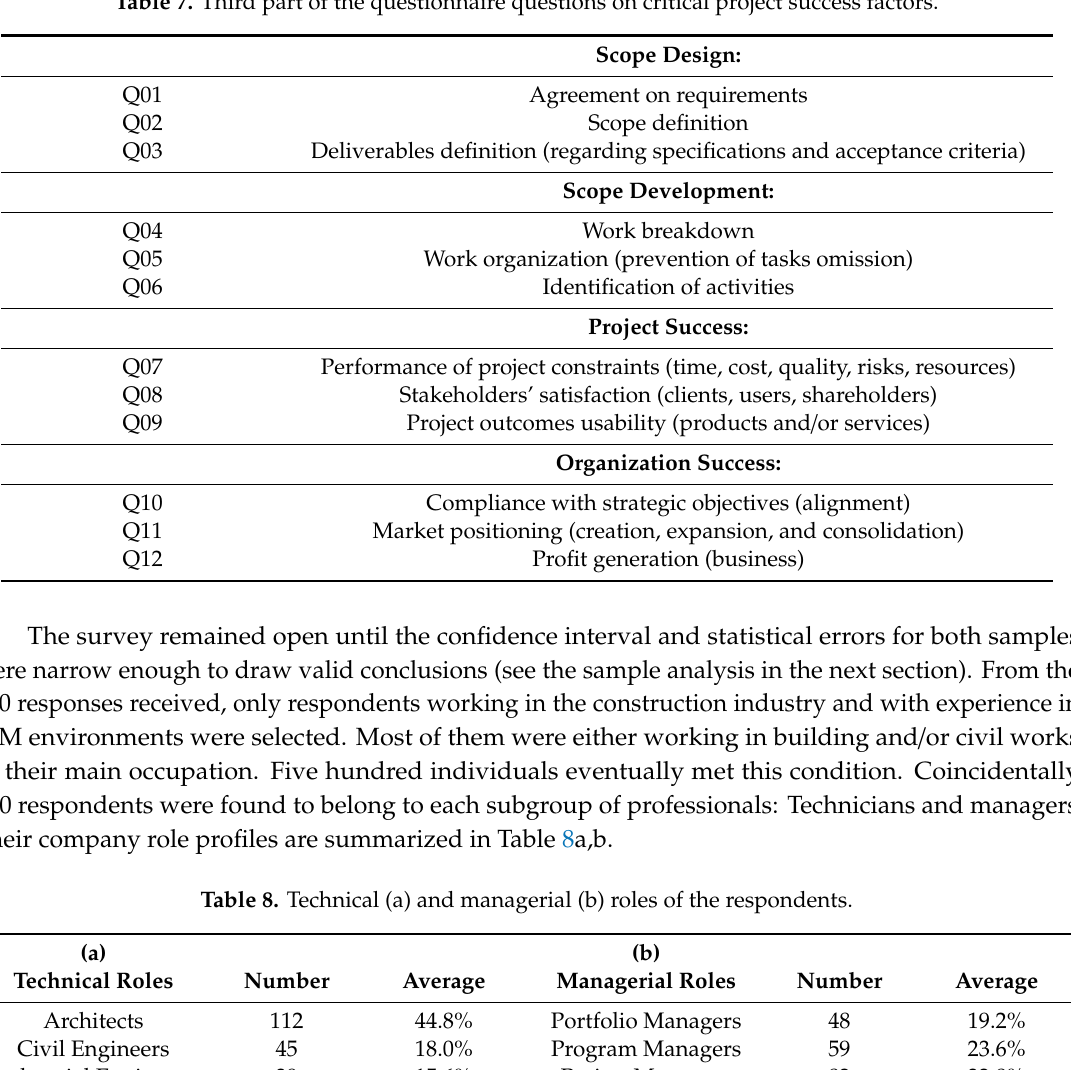
Table 7. Third part of the questionnaire questions on critical project success factors.